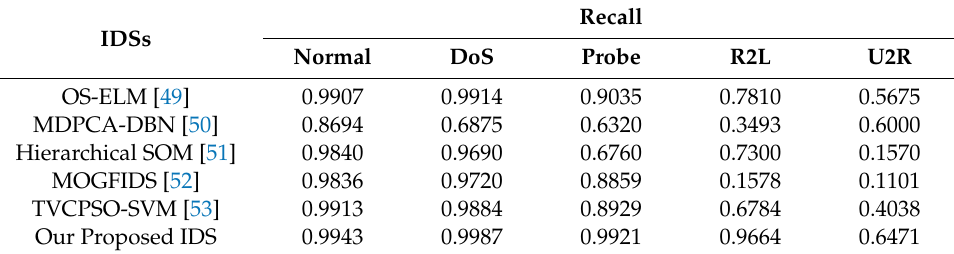
Table 5. The comparison recall for each category on the NSL-KDD dataset.